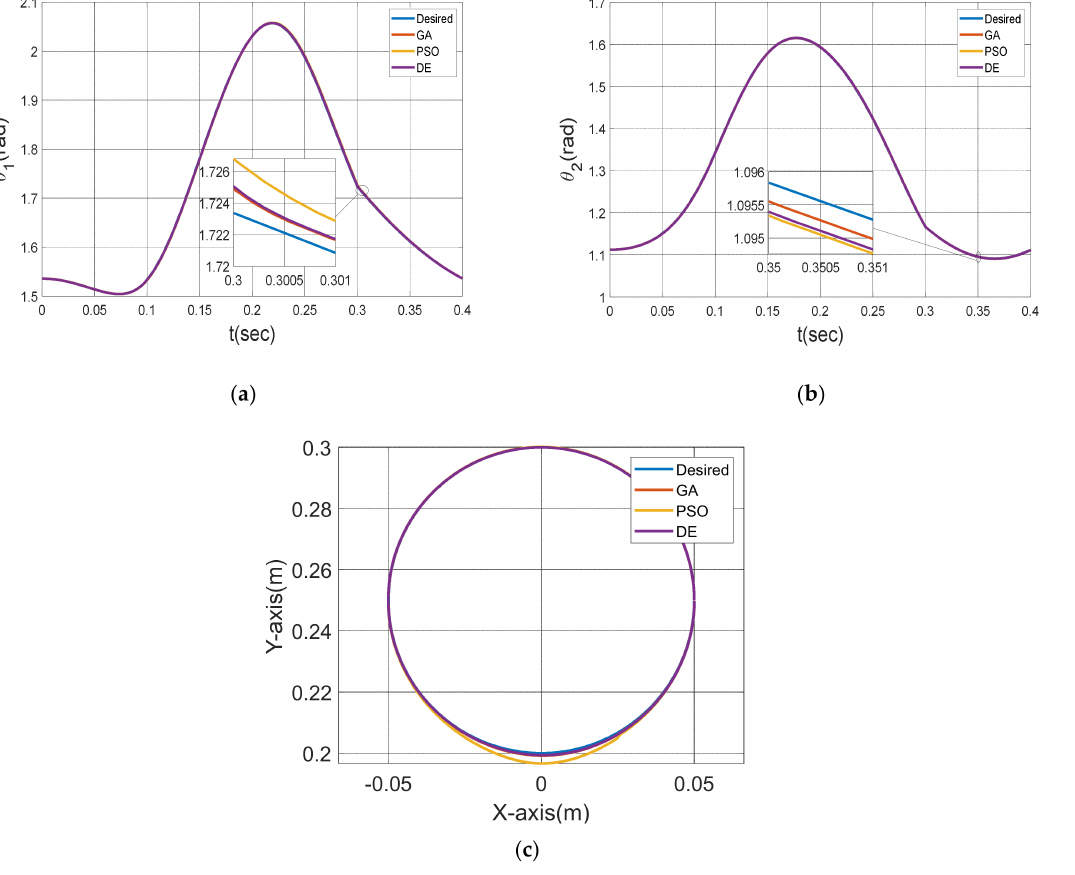
Figure 9. Control results, first motor angle ( a ) and second motor angle ( b ), applied trajectory ( c